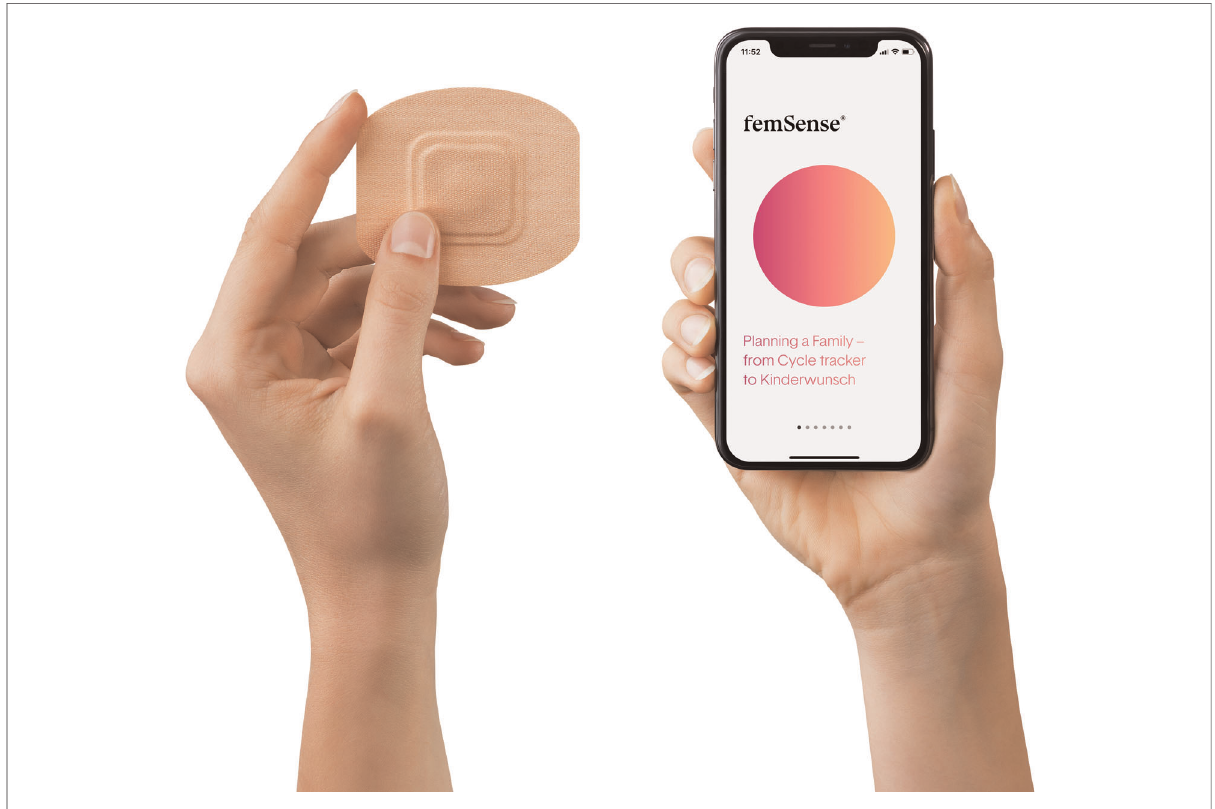
FIGURE 1 femSense ® system: The system consists of an adhesive axillary thermometer and a smartphone application (SteadySense GmbH,